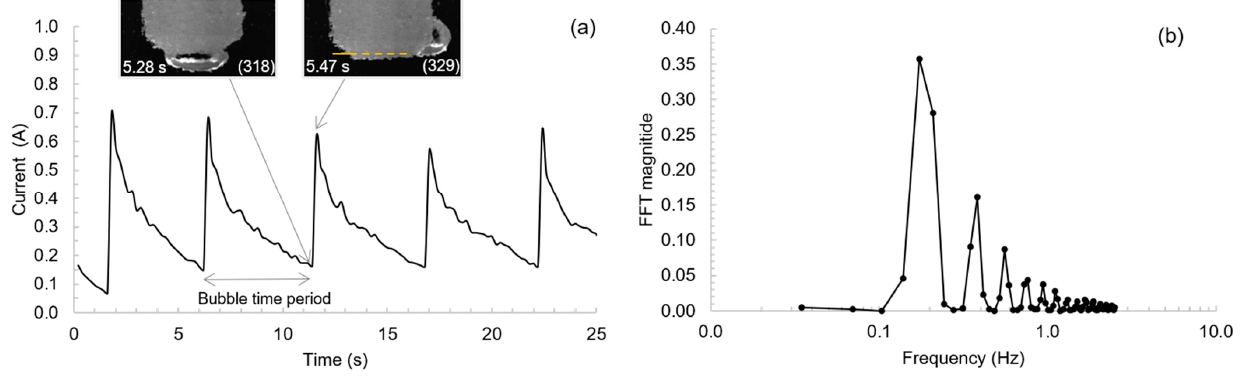
Figure 8. The horizontal anode; ( a ) current vs. time at a constant cell voltage of 1.5 V and details of the saw-tooth shaped current density-time curve. Frame (318) corresponds to the smallest current measured, and frame (329) corresponds to the current peak. ( b ) FFT (Fast Fourier Transform) spectra of current density-time data.